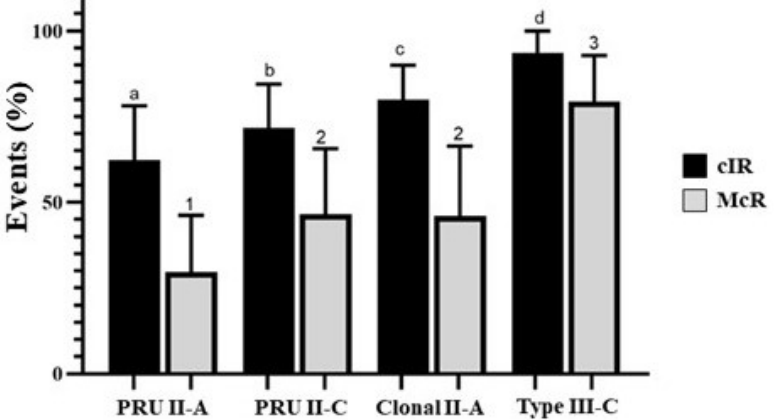
Figure 2. Cell infection rate (cIR) and multi-infected cell rate (McR) at 6 hpi in OvMØs for the